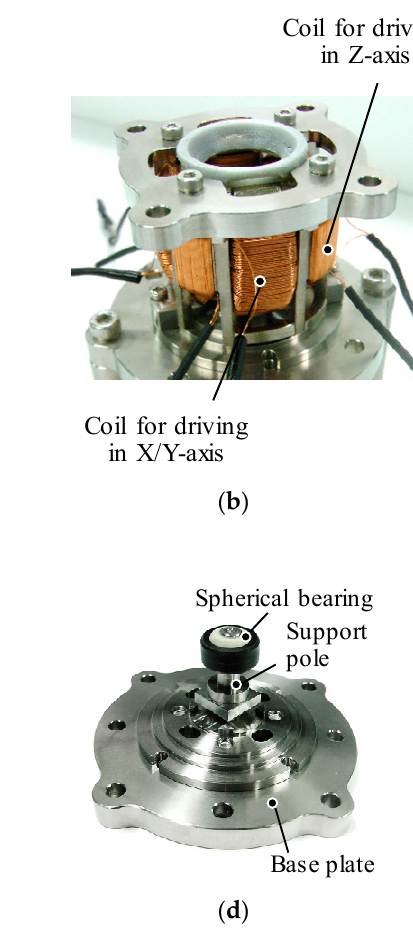
Figure 6. Overview of the prototype. ( a ) Top view; ( b ) Side view; ( c ) Mover; ( d ) Supporting mechanism without the stator.